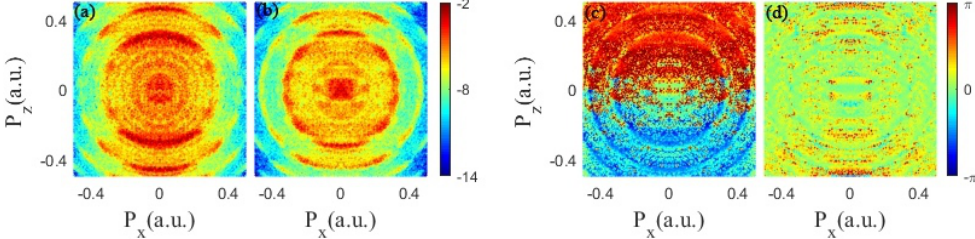
Figure 3. Left : First − order RPC ( a ) and PP ( b ) spectra obtained by fitting a series of momentum spectra with relative phase changes from 0 to 2 π ; and the other parameters were the same as Figure 1. Right : Idem, second − order RPC ( c ) and PP ( d )